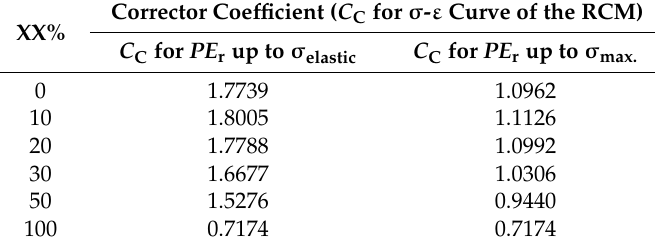
Table 8. Values C C for the different percentages of